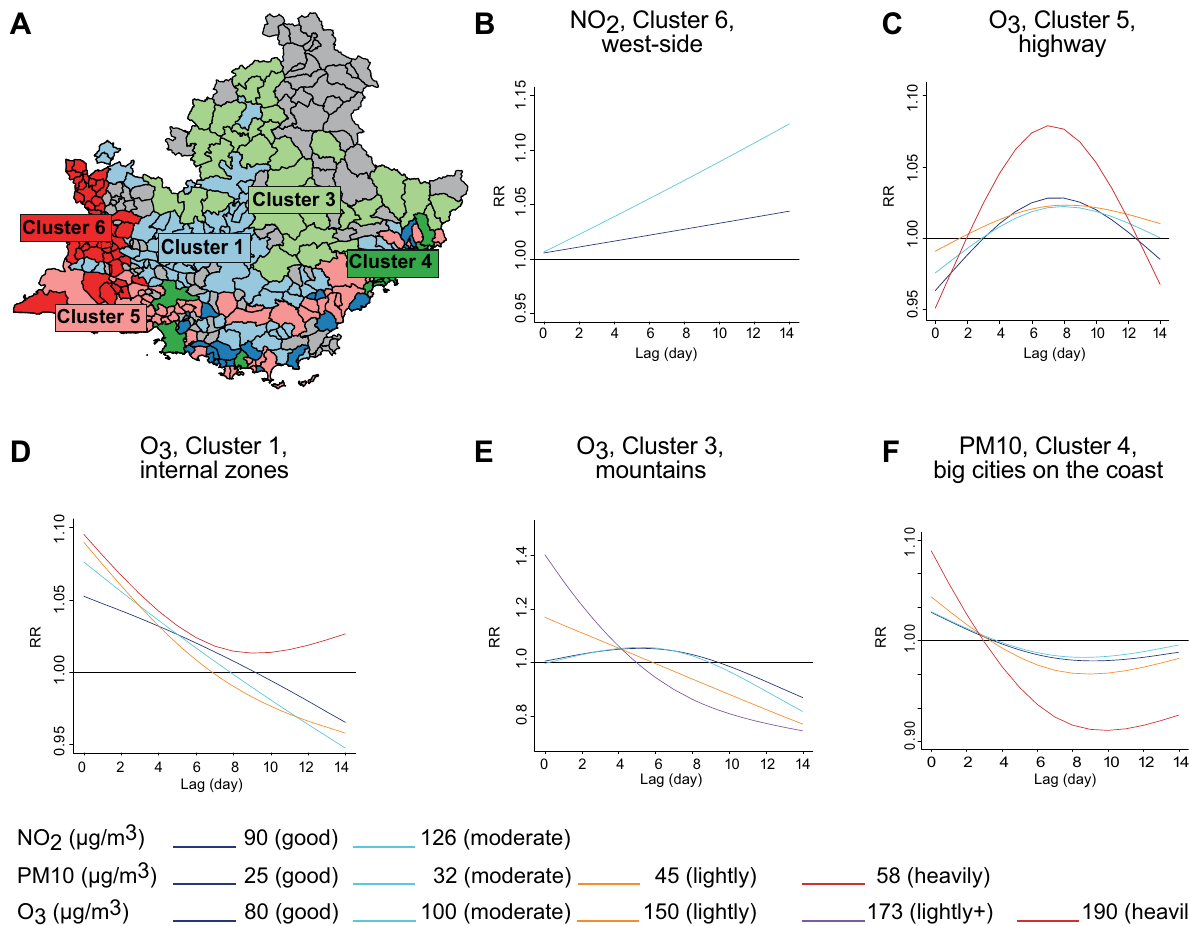
Figure 4. DLNM by pollution clusters (only significant results are reported). (A) Zones of Région Sud coloured by cluster of pollution. Colour code: light blue, cluster 1 (internal zones on the mountains); light green, cluster 3 (mountains); dark green, cluster 4 (big cities on the coast); pink, cluster 5 (highway); red, cluster 6 (west side); grey, zones not included. (B) Lag-specific effect on CD events for increases of NO2 levels over the two thresholds as indicated in the legend in the plot for zones in cluster 6 (west side). Lag-specific effect on CD events for increases of O 3 levels over the thresholds indicated in the legend in the plot for zones in cluster 5 (highway) (C) , cluster 1 (internal zones on the mountains) (D) and cluster 3 (mountains) (E) . (F) Lag-specific effect on CD events for increases of PM10 over the thresholds indicated in the legend in the plot for zones in cluster 4 (big cities on the coast). Maps were created with the R package maptools